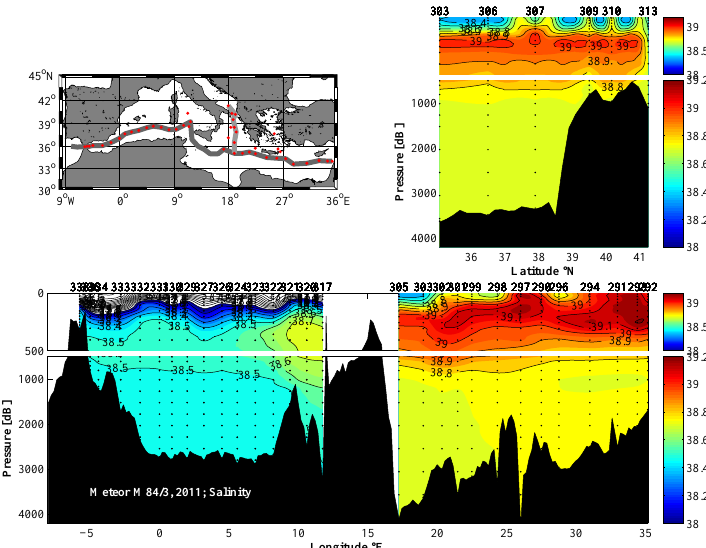
Fig. 3. Sections of salinity in the Mediterranean Sea from the Meteor cruise M84/3 in April of 2011. The top-right panel is a meridional section from the Adriatic Sea to the Ionian Sea (light gray line on the map) and the lower panel is the zonal section from the coast of Lebanon in the eastern Mediterranean Sea to through the Strait of Gibraltar (dark gray line on the map). The depth scale and the color scale are identical for all panels. The top 500m in each section are slightly expanded. No stations are shown in the Atlantic due to the very different salinities encountered there as compared to the Mediterranean